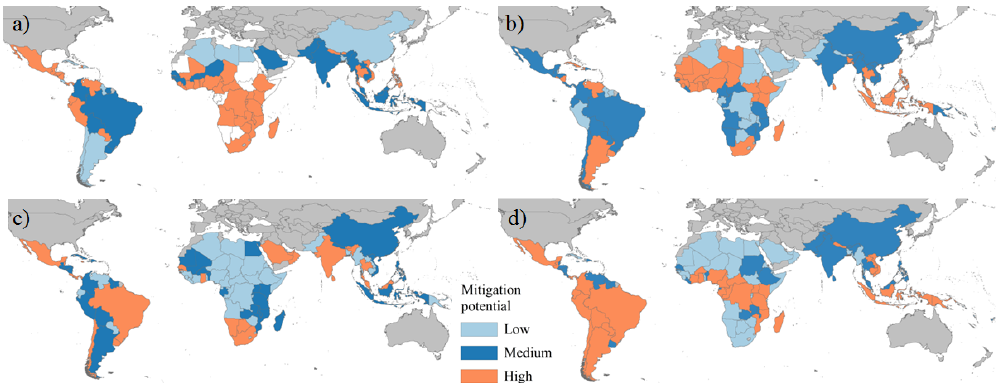
Figure 6. Mitigation potential through (a) closing the yield gap, and (b) utilizing available land, and enabling environment through (c) Gov- ernance and (d) REDD + engagement. Grey areas are outside the study area, and white areas had no available